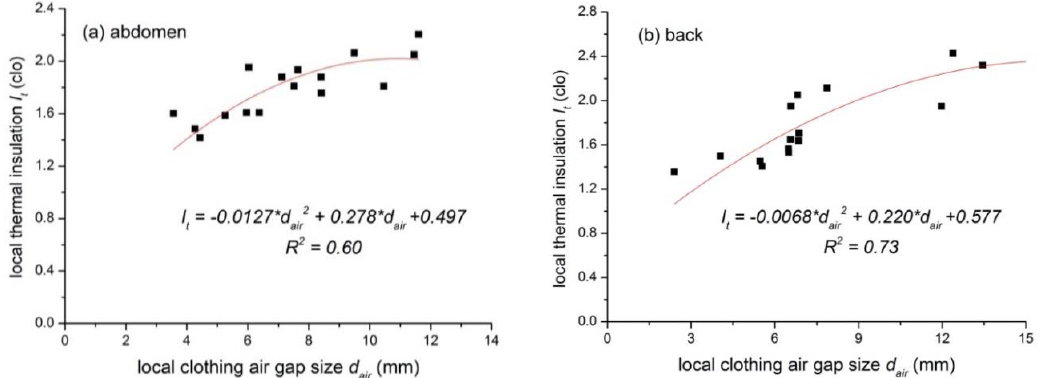
Figure 7. Relationship between the air gap size and the thermal insulation at the abdomen ( a ) and the back ( b ) with the waist belt. Table 5. Coefficients of regression equations for the abdomen and